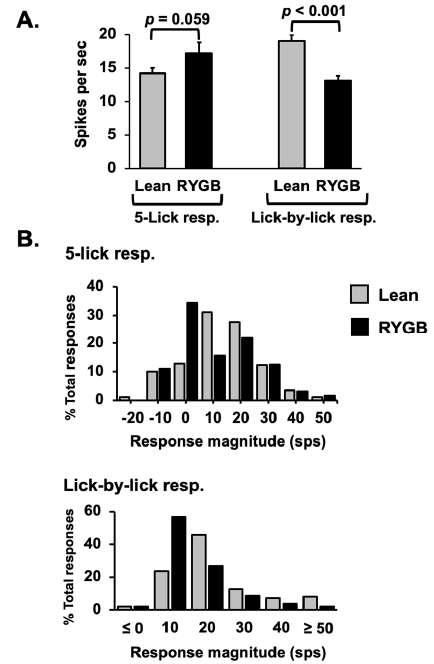
Figure 4. ( A ) Average excitatory NTS taste response magnitudes for Lean and RYGB cells across all stimuli. 5L lean, n = 129, RYGB n = 50 responses; LXL Lean, n = 241, RYGB n = 151. ( B ) Distribution of response magnitudes across the population of taste ‐ responsive cells.